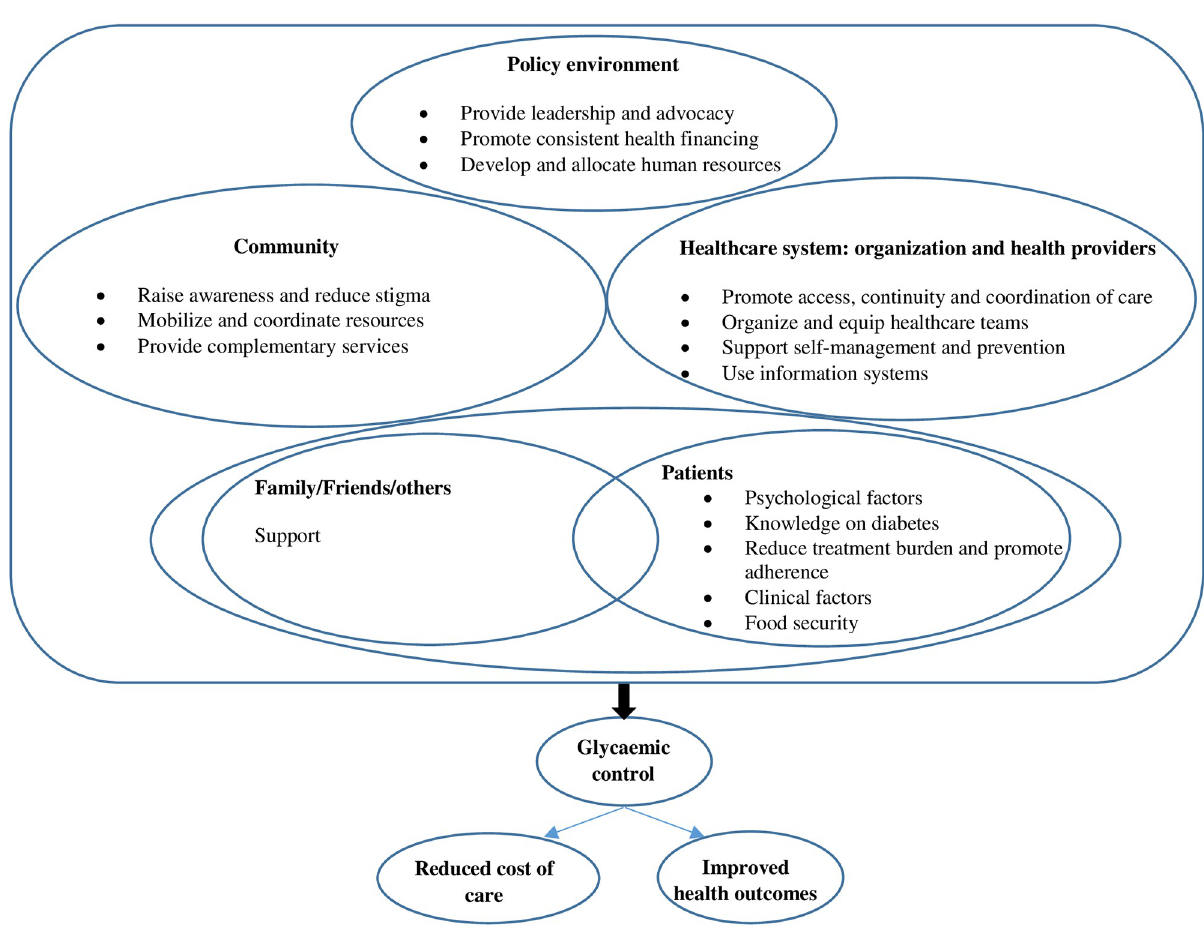
Fig 1. Conceptual model for glycaemic control among patients with type 2 diabetes mellitus in Kinshasa, DRC.